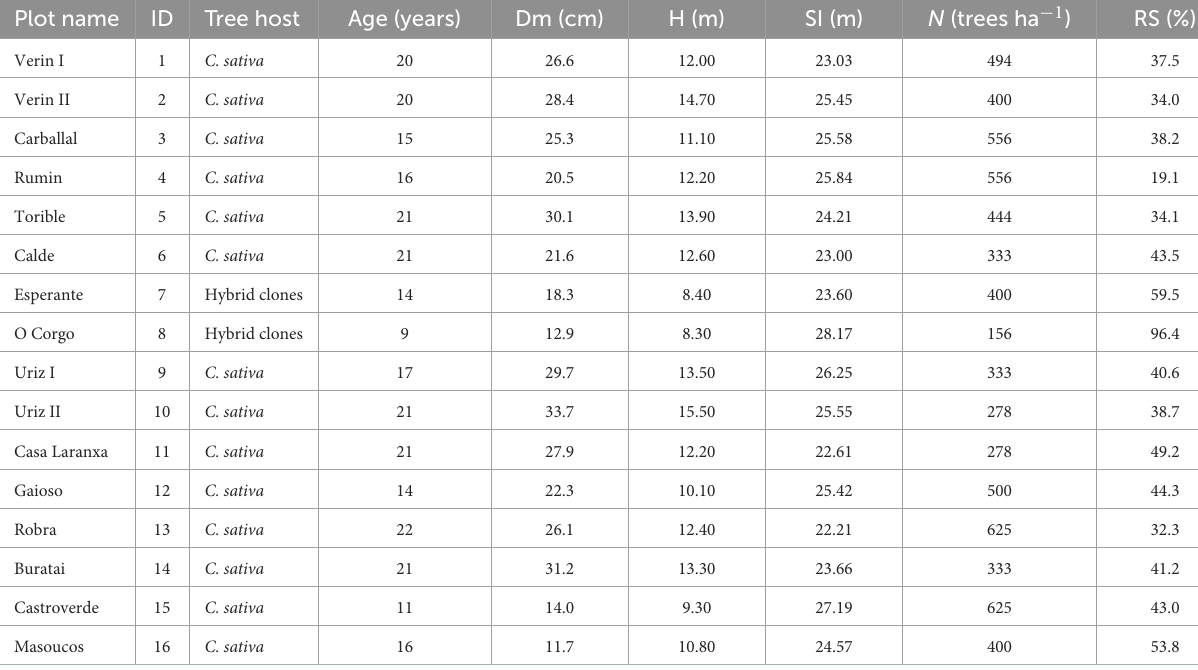
TABLE 1 Stand characteristics of the 16 study